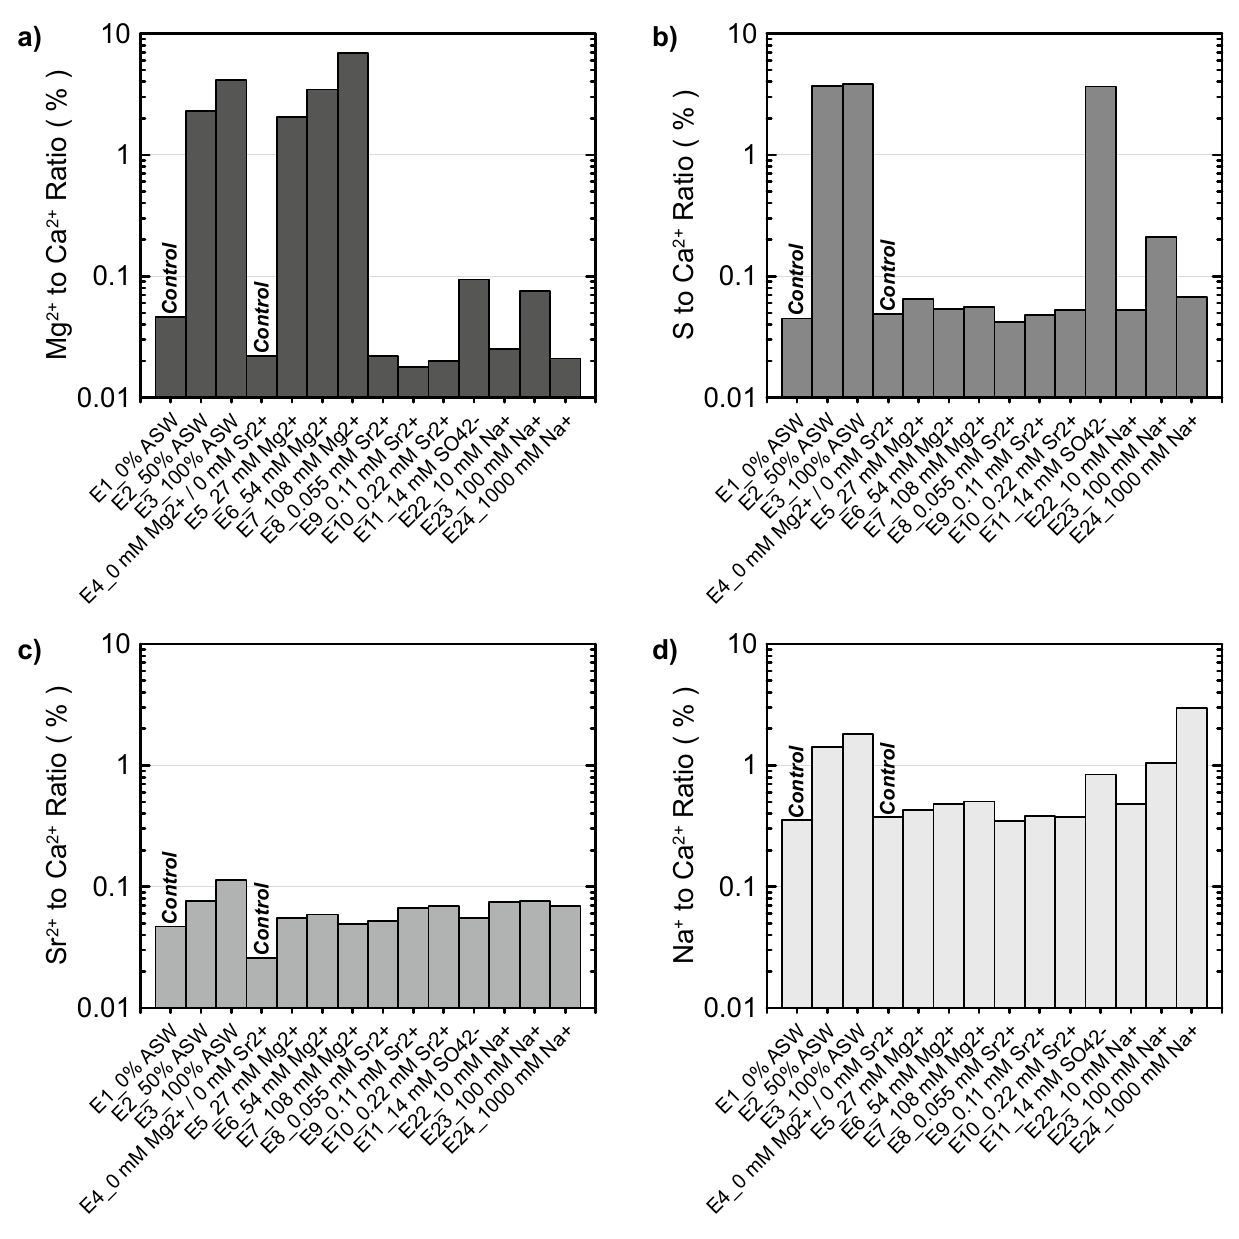
Figure 14. Comparison of ( a ) Mg 2+ to Ca 2+ ion ratios, ( b ) S to Ca 2+ ion ratios, ( c ) Sr 2+ to Ca 2+ ion ratios, ( d ) Na + to Ca 2+ ion ratios obtained from precipitate composition analyses for select